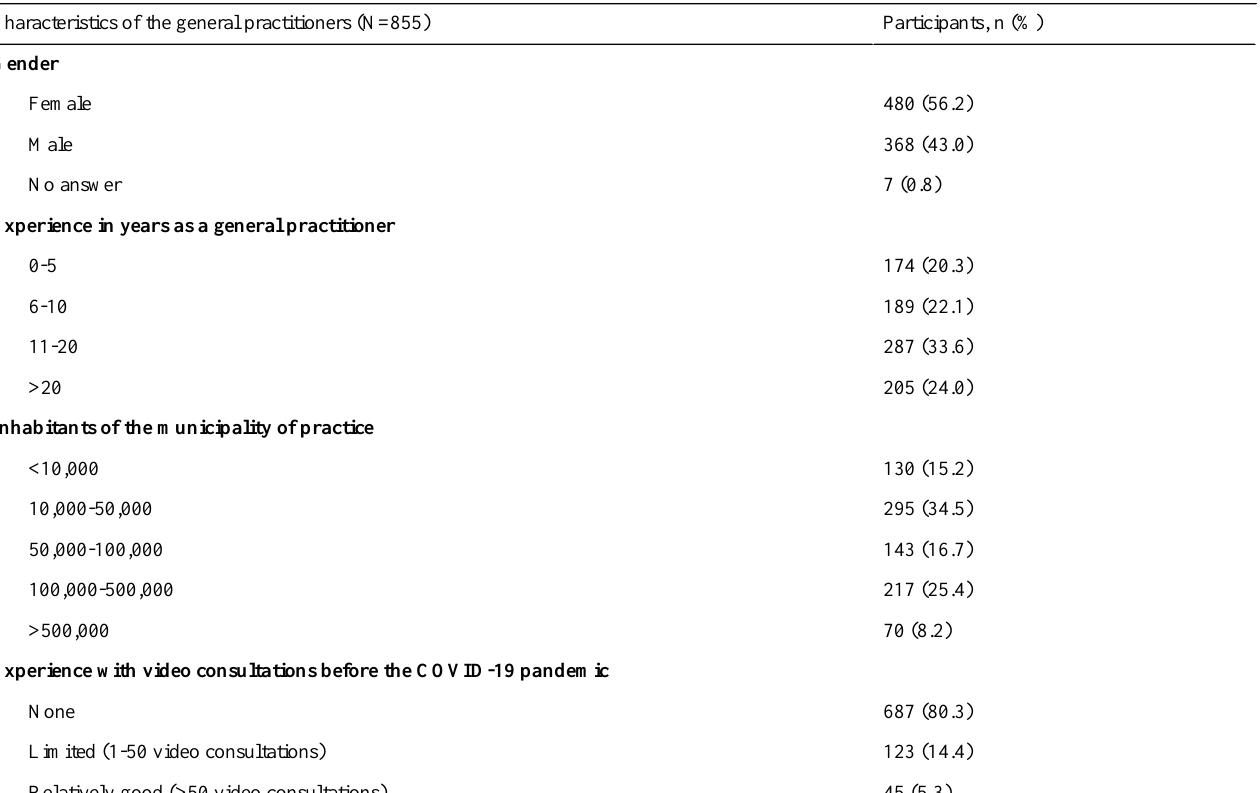
Table 1. Characteristics of the 855 general practitioners who evaluated one or more video